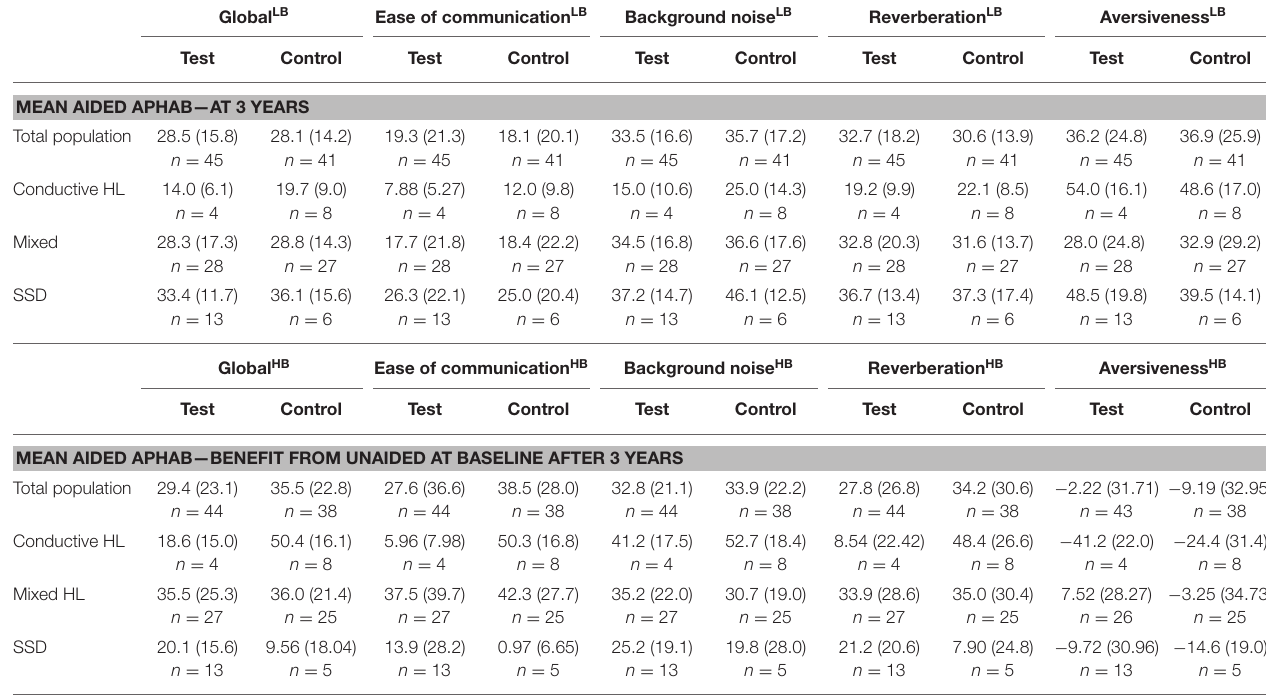
TABLE 6B | Abbreviated profile of hearing aid benefit after 3